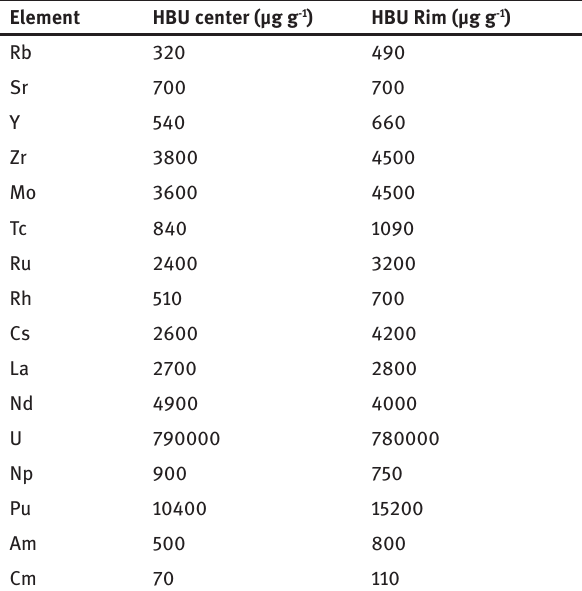
Table 2: Chemical inventory for the pellet in the center and rim region [15].